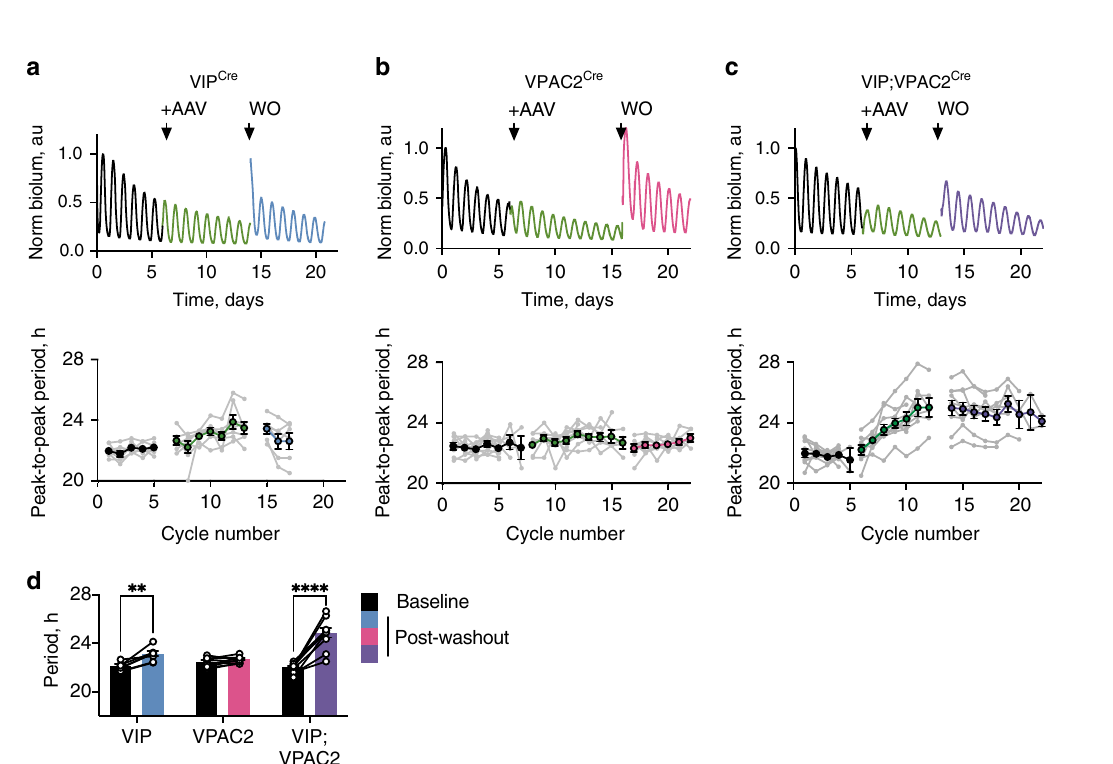
Fig. 5 Targetted optogenetic activation of VIP cells sets ensemble phase, whereas activation of VPAC2 cells does not. a Representative merged fl uorescence/bright fi eld micrographs of VIP ChR2::EYFP (left) and VPAC2 ChR2::EYFP (right). b Representative 470 nm (blue) or 625 nm (red) stimulated normalised Per2::Luciferase trace from VIP ChR2::EYFP SCN. Inset: phase-delay third cycle post-stimulation. c Phase response curve (PRC) for VIP ChR2::EYFP SCN stimulated at 470 nm (blue) or 625 nm (red/pink) (* p = 0.032, **** p < 0.0001). d , e As in ( b , c ), but for VPAC2 ChR2::EYFP SCN. f Combined PRCs for 470 nm-stimulated VIP ChR2::EYFP (blue) and VPAC2 ChR2::EYFP (pink) SCN (*** p = 0.0002). g , h Normalised bioluminescence traces for Cry-null SCN expressing ( g ) pan-neuronal ChR2::EYFP or ( h ) VIP ChR2::EYFP stimulated at 470 nm (blue) or 625 nm (red) alongside paired summary data (right) (** p = 0.008, *** p = 0.0009). i Micrographs showing VIP ChR2::EYFP Cry-null SCN (Per2::Luciferase, ChR2::EYFP and merge) (left) alongside Per2::Luciferase time- series (upper) and ChR2::EYFP (lower) before and after optogenetic stimulation. j Example spatial bioluminescence change (left) and VIP Cre -dependent EYFP intensity (right) in VIP ChR2::EYFP SCN slice. k Averaged bioluminescence traces within (EYFP intensity > 1, orange) or outside (EYFP intensity < 1, blue) EYFP regions (left) in VIP ChR2::EYFP SCN, with paired summaries (right) measured over interval indicated by horizontal line. l Cumulative distributions of bioluminescent changes within (orange) or outside (grey) EYFP regions in VIP ChR2::EYFP SCN. Scale bars = 250 µ m. Arrowheads: stimulation. PRCs: small points represent individual slices; large points represent mean ± SEM. Line plots: lines and shading represent mean ± SEM. Histograms: paired points represent individual slices; bars represent mean ± SEM. PRCs: n ≥ 5 for each phase, explicit n values are given in Supplementary Table 1; Cry-null recordings: PMT: neuronal ChR2::EYFP n = 7; VIP ChR2::EYFP n = 6 SCN; Imaging: n = 5 SCN. Statistics: c , b, f two-way ANOVA; g , h , k , paired two-tailed t -test; l repeated-measures two-way ANOVA. Only signi fi cant comparisons ( p < 0.05) are shown. Source data are provided as a source data fi le.